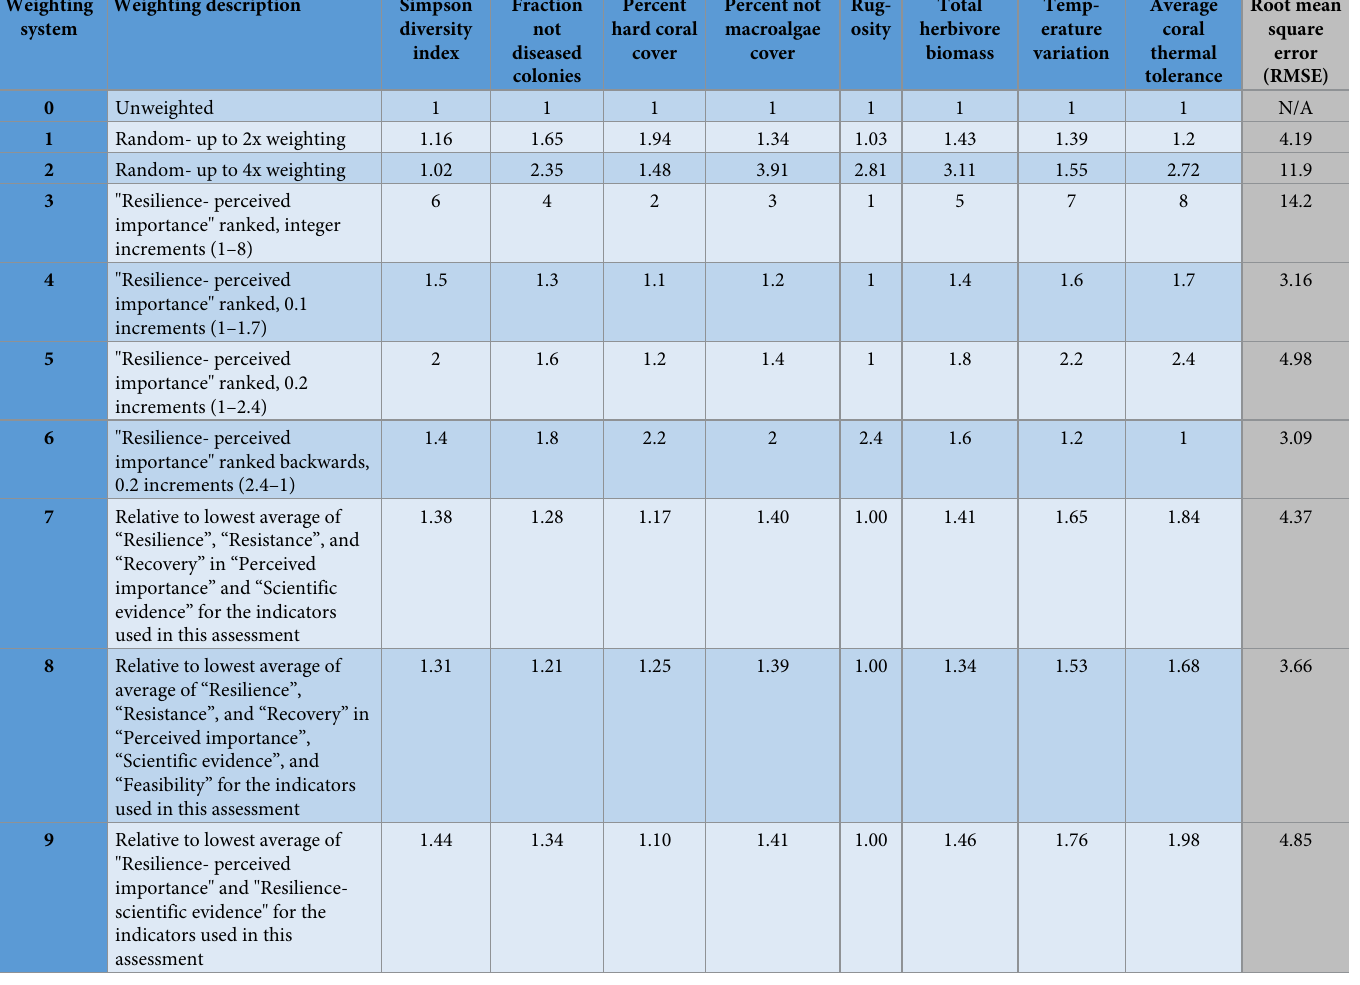
Table 1. Weighting systems for resilience indicators. A larger value means the indicator is given more weight in calculation of the resilience score. Weighting systems 3–9 are based on Table 2 in [12]. Root mean square errors (RMSE) are from the comparison of weighted indicator resilience ranks against unweighted indicator resilience